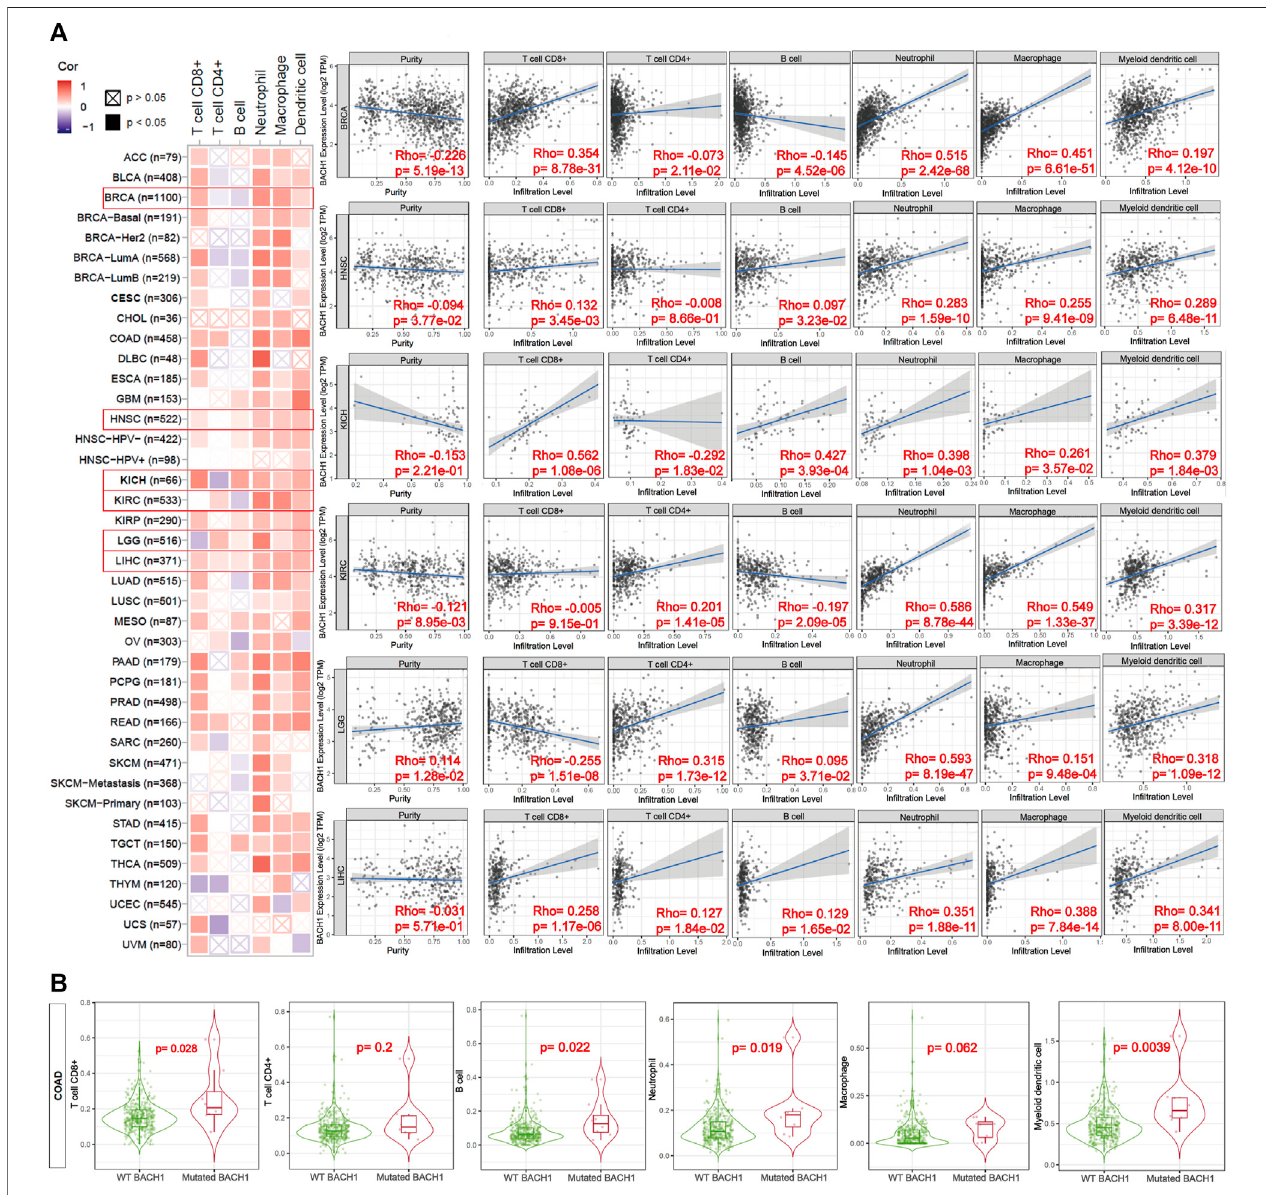
FIGURE 5 | Correlation of the expression or mutation of BACH1 with immune in fi ltration. (A) Correlation of BACH1 Expression with Immune In fi ltration (B) Correlation of BACH1 mutation with Immune In fi ltration.